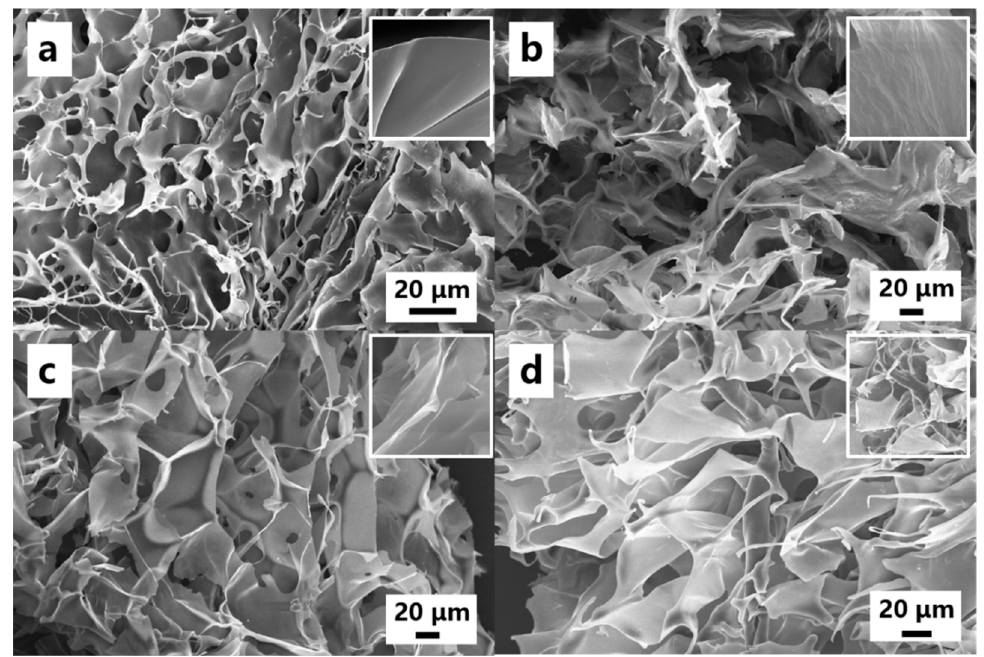
Figure 2. SEM images of the CSAs/GO aerogels. ( a ) GO-0, ( b ) GO-0.5, ( c ) GO-1.0, ( d ) GO-1.5, and the insets are selected magnifications.